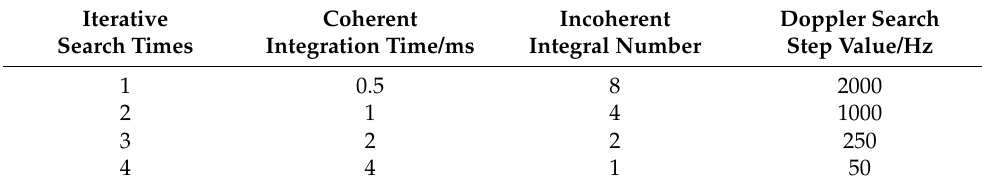
Table 2. ILS parameters.